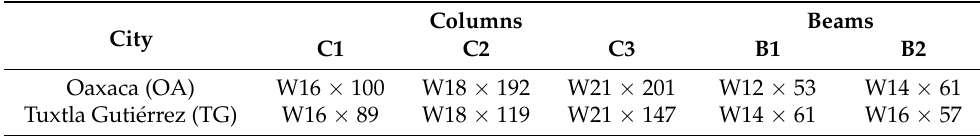
Table 3. Steel W-type sections of the 7-story